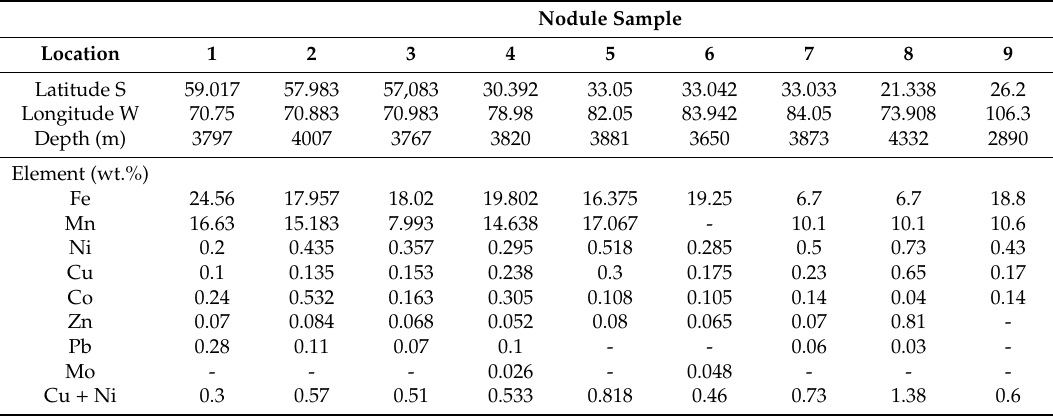
Table 2. Location, depth, and chemical analysis of manganese nodules within diverse marine regions surrounding Chile (labeled as numbers 1–9 in Figure 5). (Adapted from Garc í a et al. [61].) Nodule Sample Latitude S